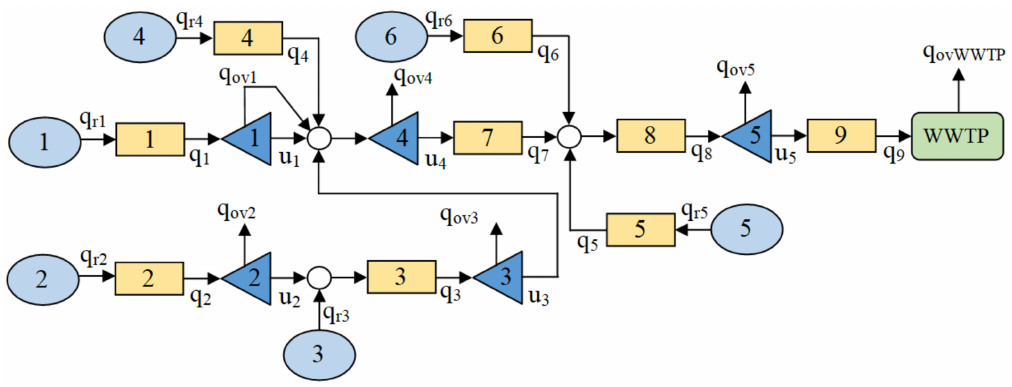
Figure 2. Simplified sewer block